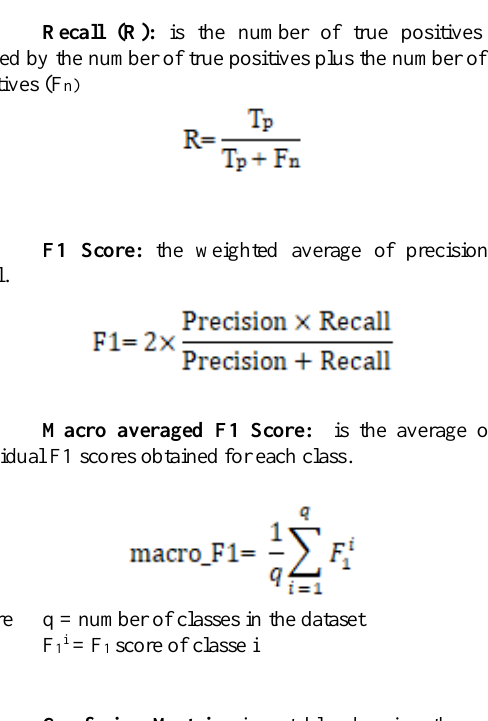
Confusion Matrix: is a table showing the correct predictions and the incorrect types of predictions.